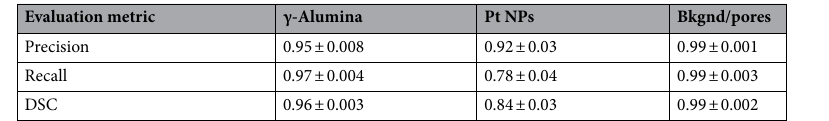
Table 1. Evaluation results from the validation data set. All the values are in the form of mean ± 95% confidence